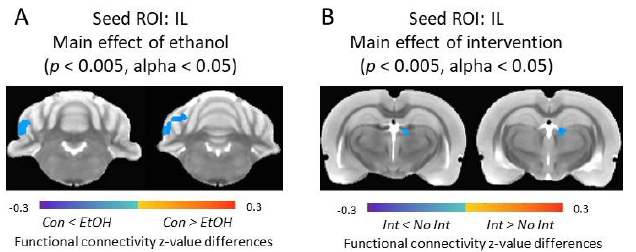
Figure 6. Alterations of IL functional connectivity in female rats. (A) Main effect of ethanol was detected in cerebellar areas. Color code: connectivity differences between Con and EtOH animals. (B) Main effect of intervention was detected in the habenular complex area. Color code: connectivity differences between receiving the intervention (Int) and those that did not (No Int). ROI=Region of Interest, IL=Infralimbic Cortex, Con=Control, EtOH=Ethanol.